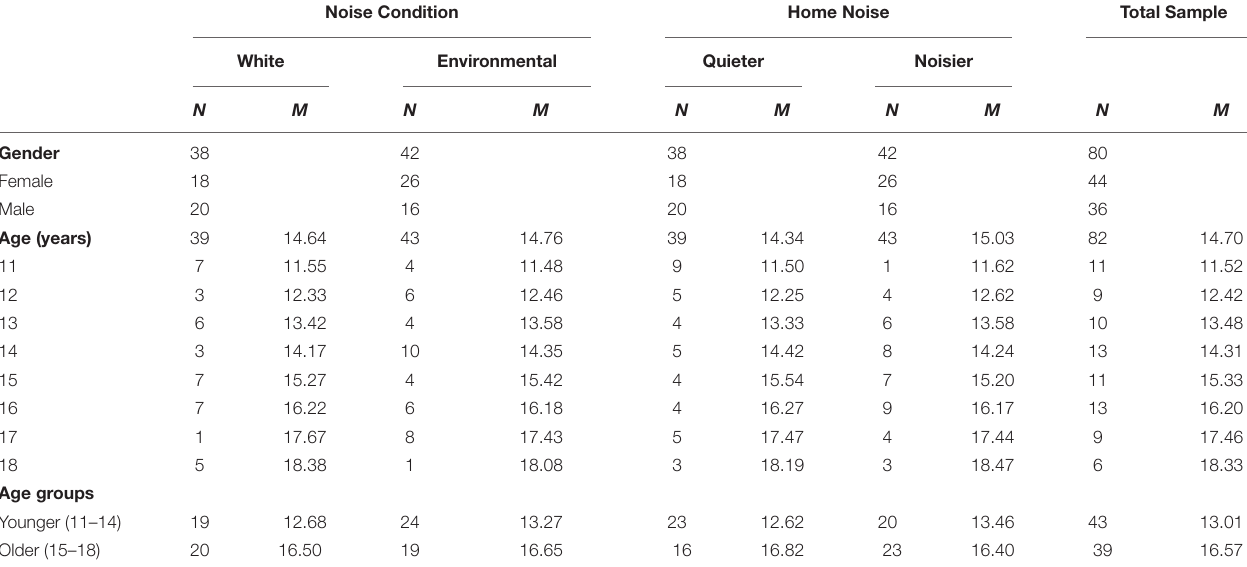
TABLE 5 | Breakdown of subject characteristics within both experimental Noise Condition and Home Noise grouping based on gender and age. Noise Condition Home Noise Total Sample White Environmental Quieter